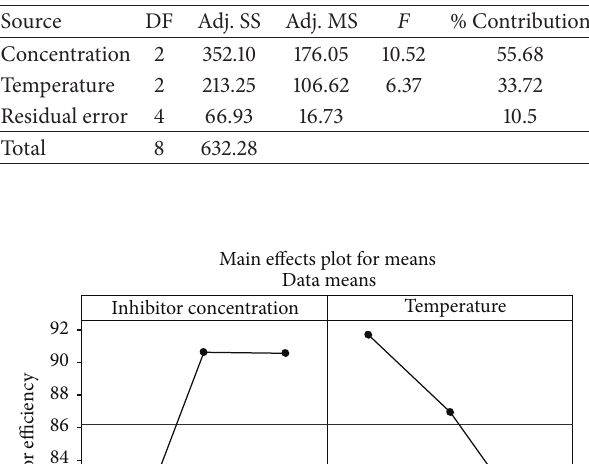
Table 2: Numerical values of ANOVA.